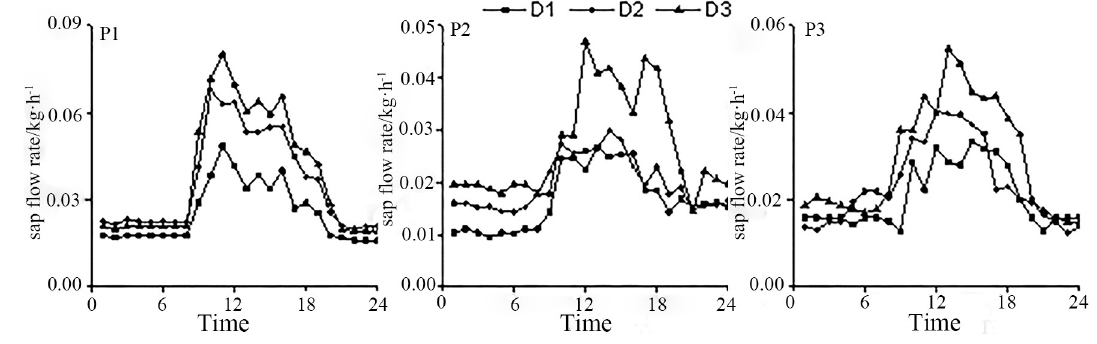
Fig 4. Changes in sap flow of Salix psammophila .